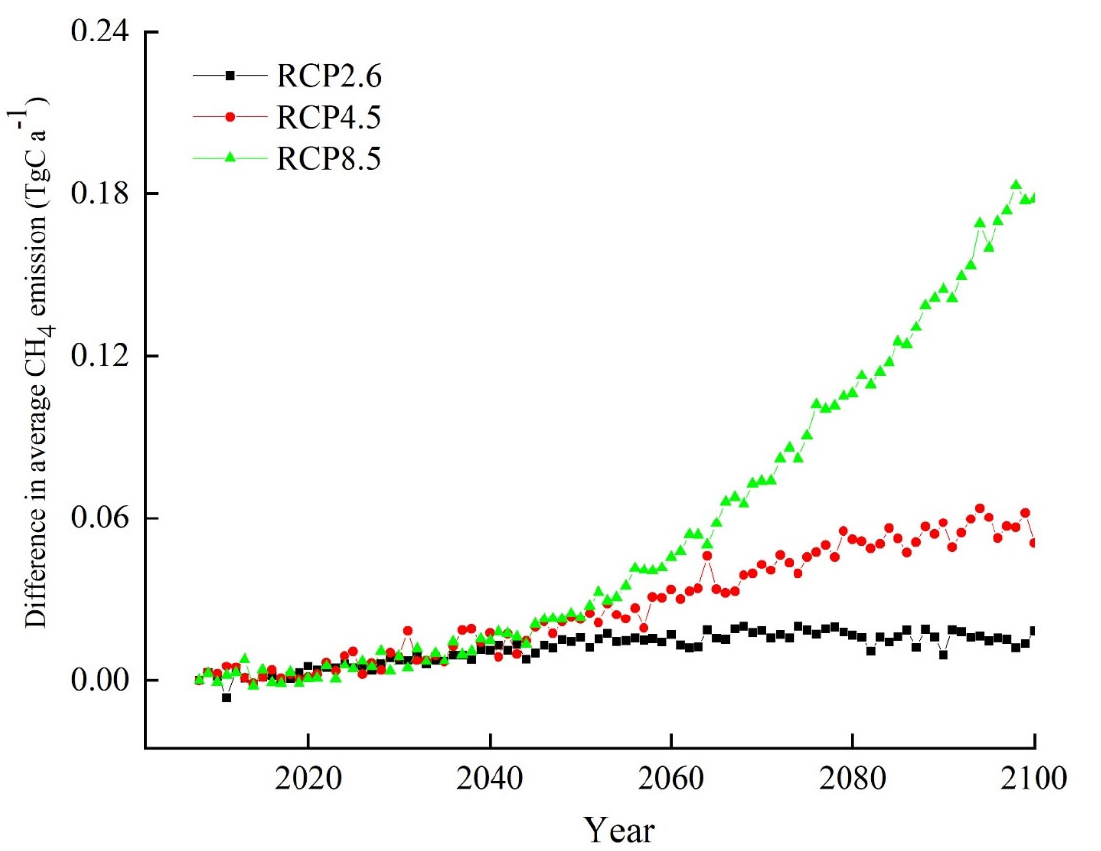
Figure 3. Difference in average CH 4 emission from wetlands when models stipulated increasing or constant CO 2 . Average values were calculated across all 24 CMIP5 models, and results under each RCP are shown. Positive differences indicate higher average emission with increasing CO 2 .